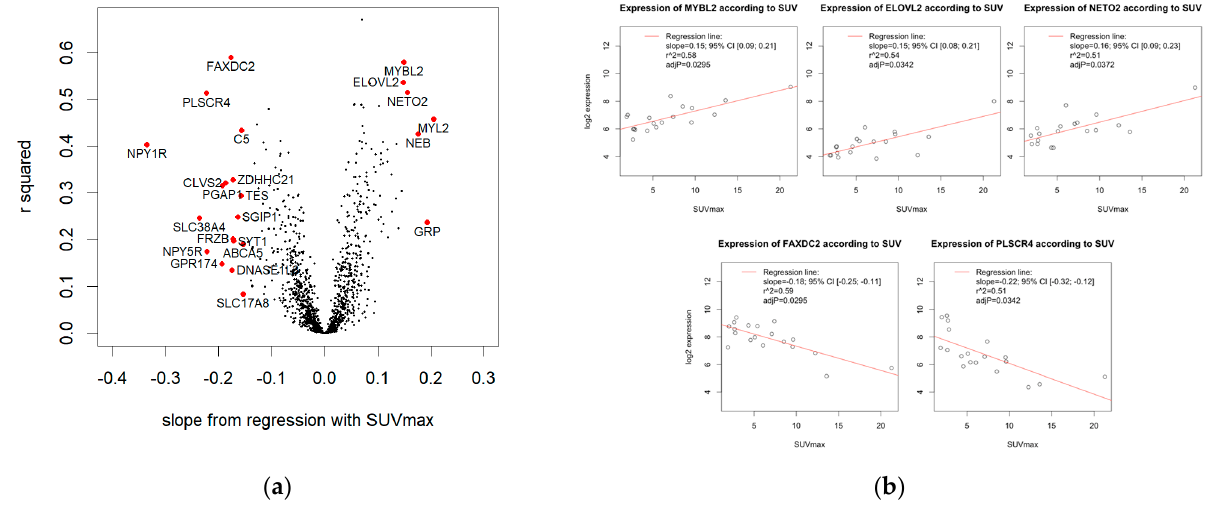
Figure 4: Results from linear regression modeling of SUVmax and gene expression. ( a ) Volcano plot. For each gene tested, the slope of the regression line and r 2 (Pearson correlation) are given. Five genes are significantly correlated with SUVmax with adjusted p -value < 0.05 (FAXDC2, MYBL2, PLSCR4, ELOVL2, and NETO2). In addition, 23 genes show a high effect size of abs(slope) > 0.146 (labelled genes). ( b ) Scatterplots of significant correlations of SUVmax and log2 gene expression. Expression of MYBL2, ELOVL2, and NETO2 is positively associated with SUVmax (top row), whereas FAXDC2 and PLSCR4 are negatively associated (bottom row).